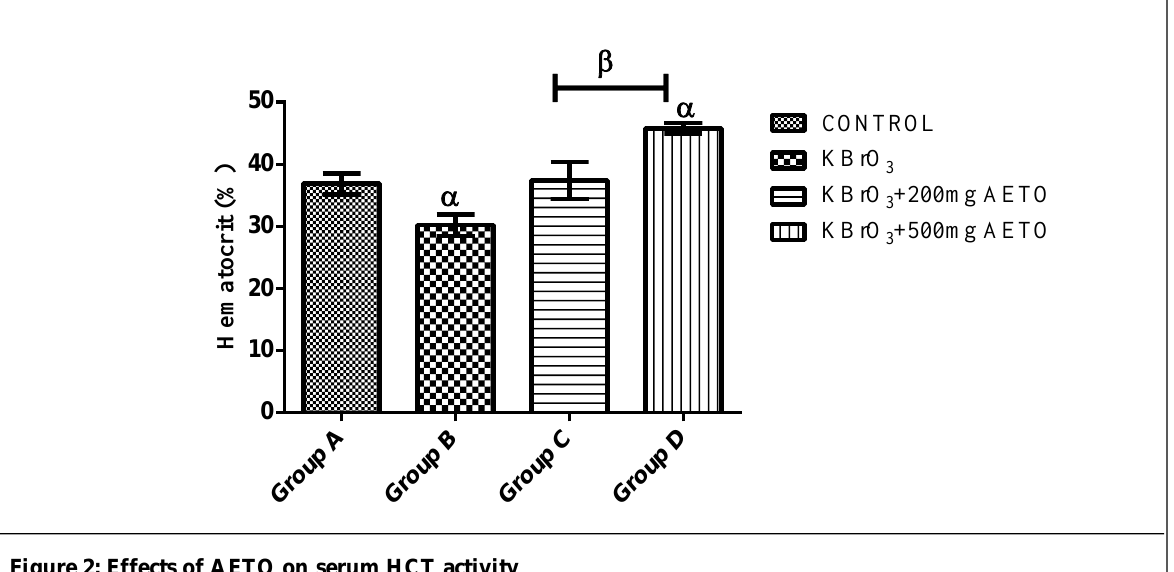
Figure 2: Effects of AETO on serum HCT activity